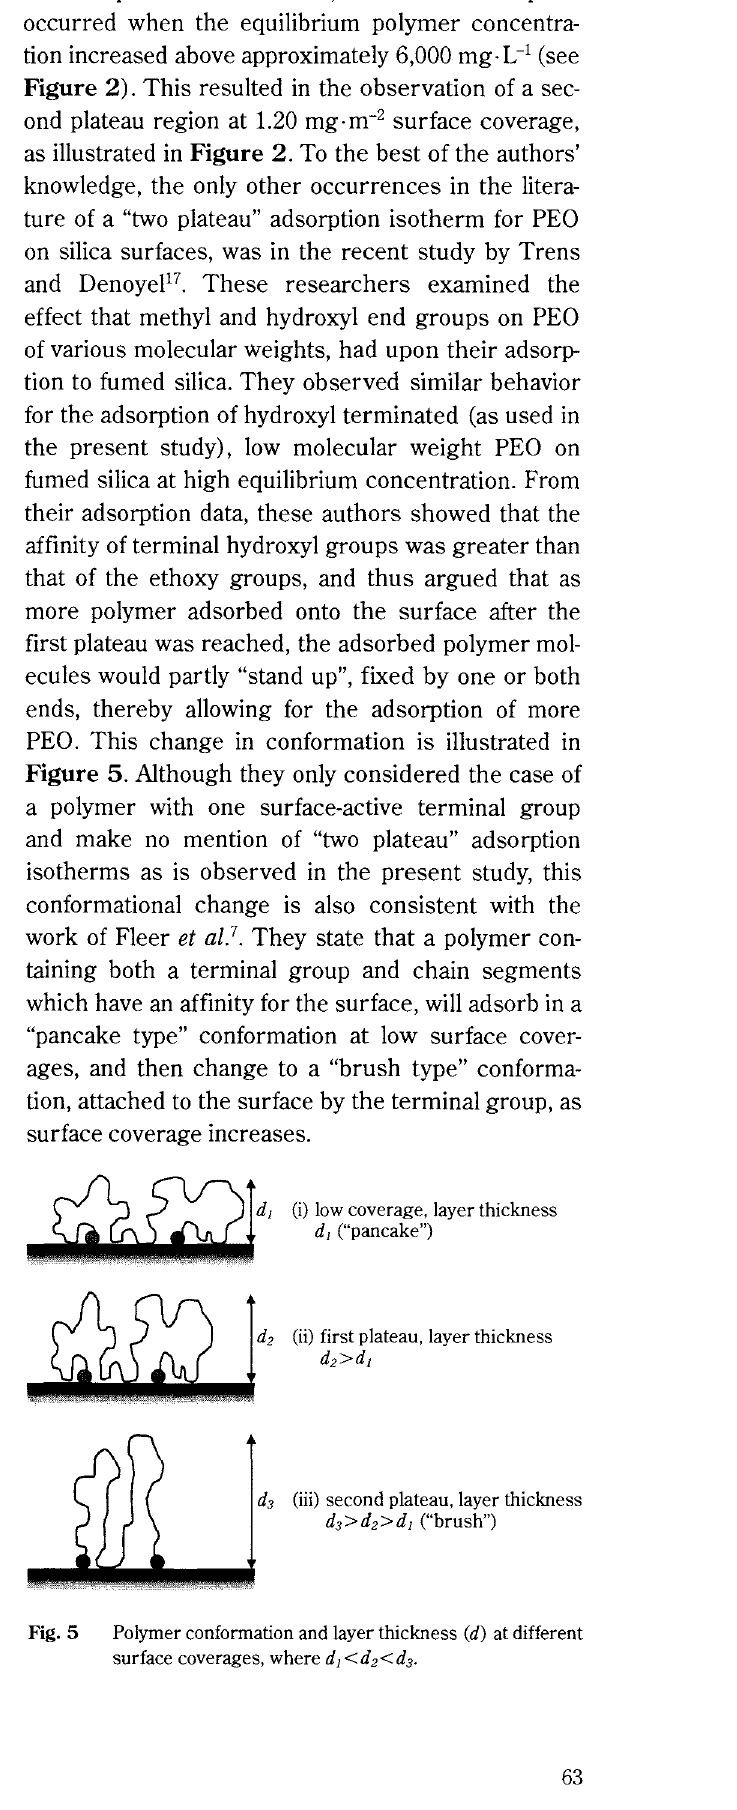
Fig. 5 Polymer conformation and layer thickness (d) at different surface coverages, where